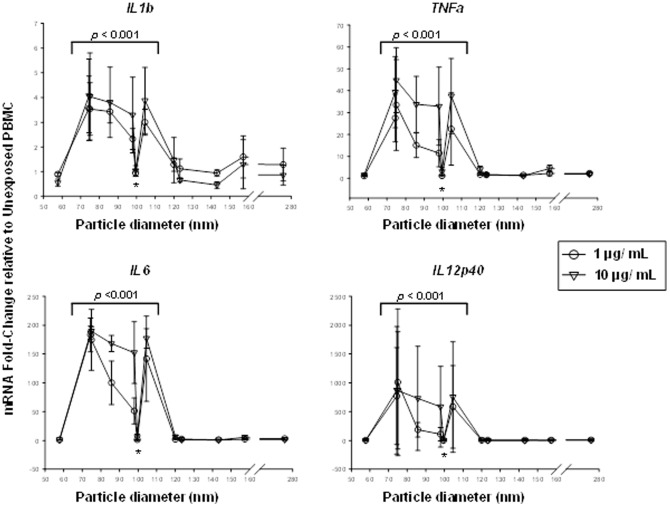
Effect of the Size of DEP and DEP-Env Particles on the Bioreactivity of Human PBMC.
IL1b, TNFa, IL6, and IL12p40 mRNA fold-changes (Y-axes) in PBMC (from 3 donors) shown in 
Figure 3
 are plotted as a function of mean particle diameter in nanometers (x-axes). All particles in the size range from 70 to 110 nm, with one exception (asterisk *), showed significantly higher bioreactivity (p<0.001) compared to the particles below or above this size range.